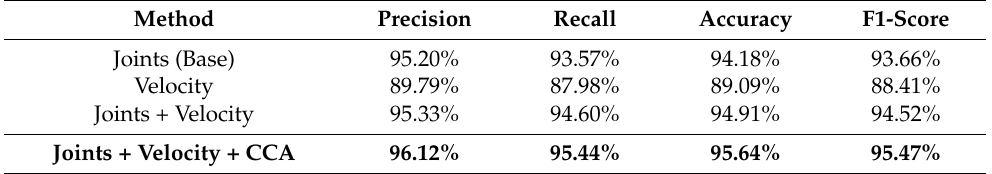
Table 4. Performance evaluation of the proposed HAR method on the MSR-Action3D dataset. Method Precision